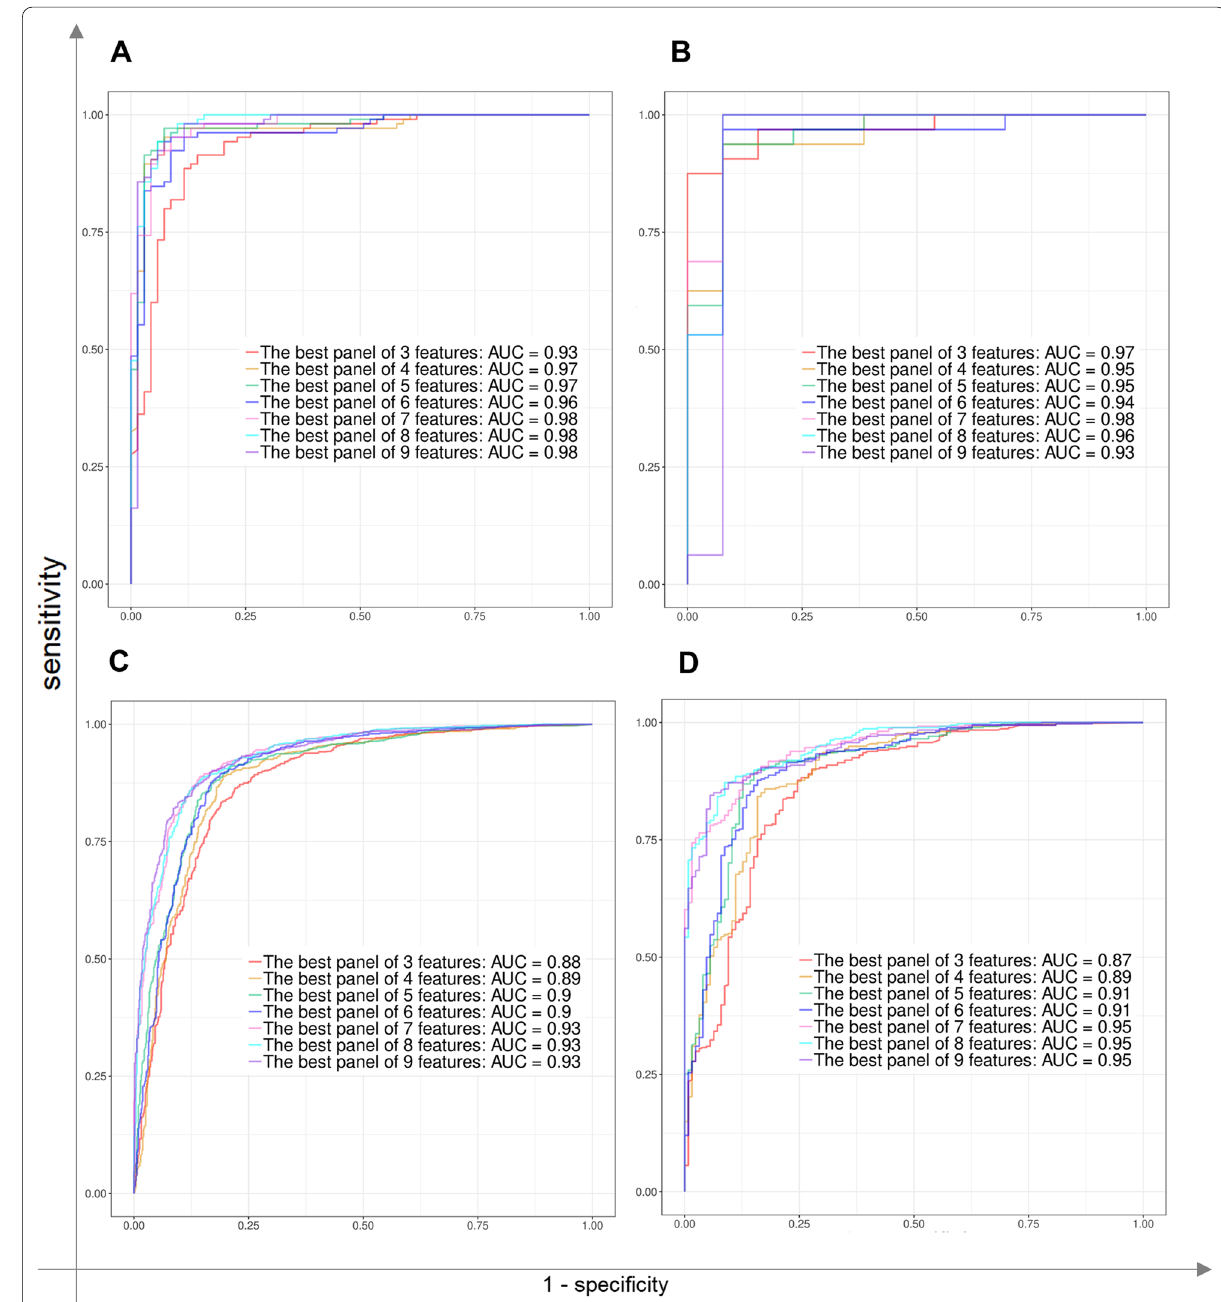
Fig. 7 The ROC curves: These ROC curves illustrate the sensitivity, 1-specificity, and AUC associated to phase I ( A and C ) and phase II ( B and D ) for whole blood and nasopharyngeal samples among the top 3 to 9 features,